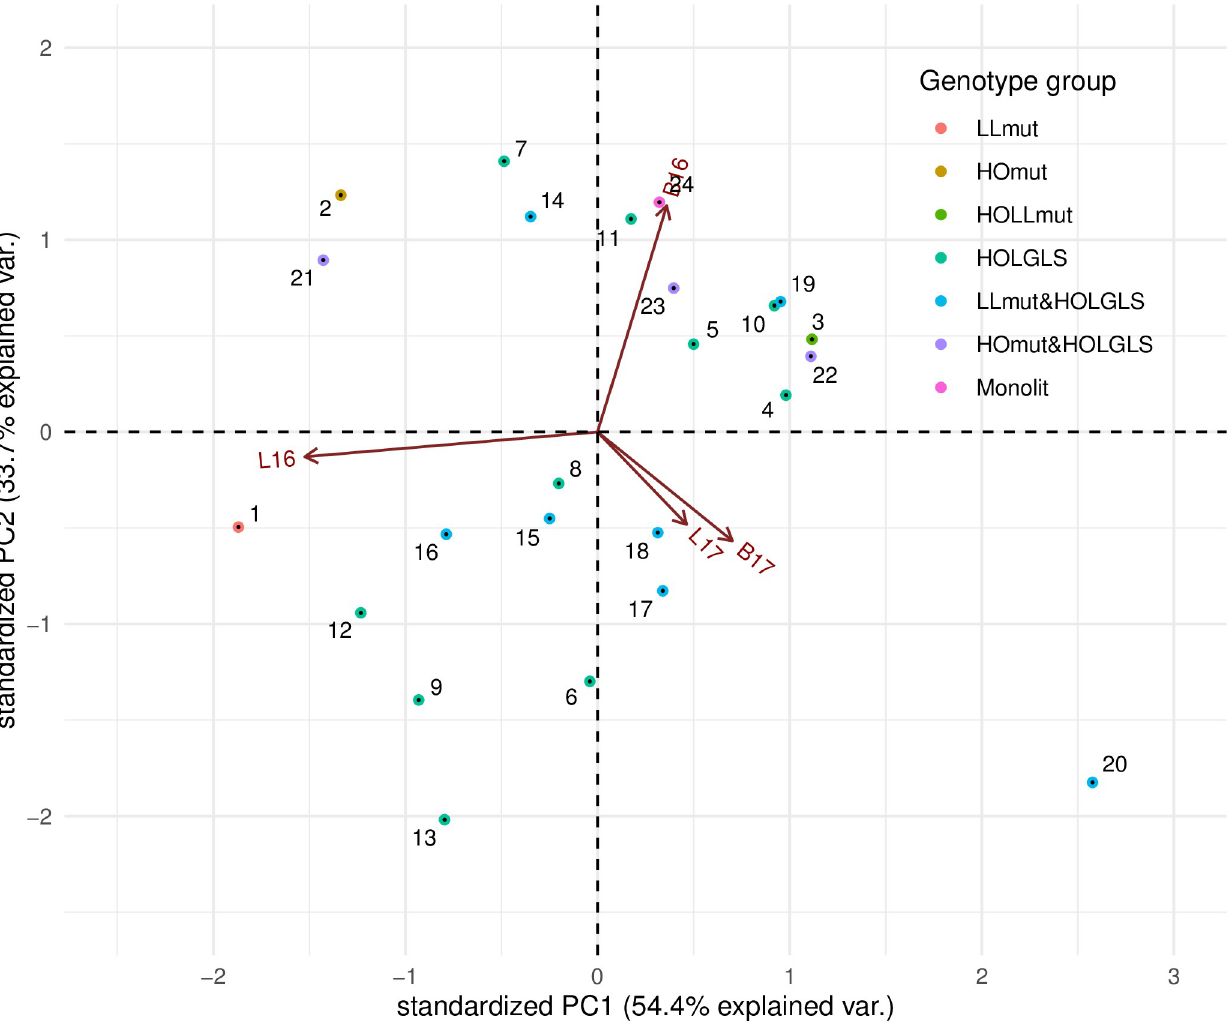
Fig 4. Biplot for G × E effect estimates of linolenic acid content in genotypes in relation to the resultant environment. Genotypes are indicated by points and environments by lines. B—Borowo location; L—Lagiewniki location; 16–2015/2016 growing season; 17–2016/2017 growing season.